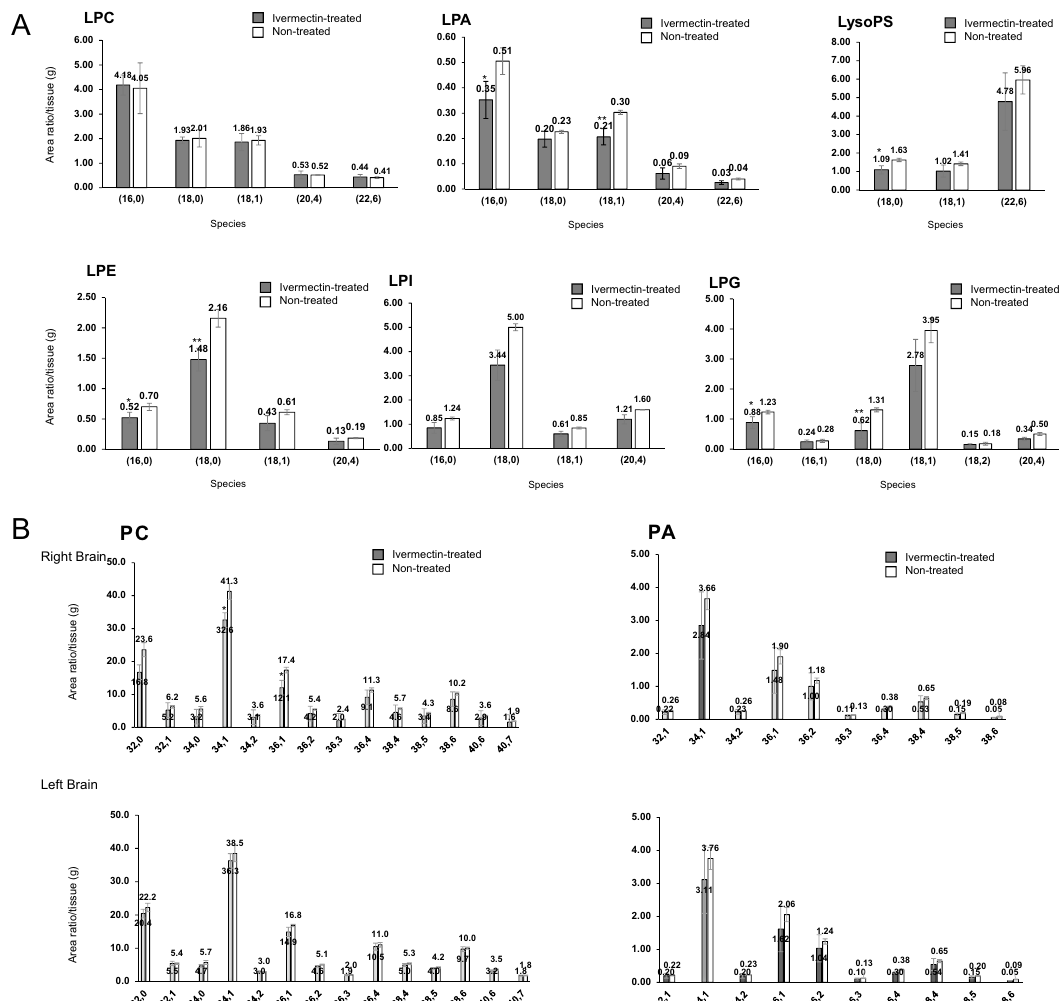
Figure 5. Quantitative change of LPLs, PC and PA in the brain RN mice by IVE-treatment. ( A ) Quantitative comparison of lysophosphatidylcholine (LPC), lysophosphatidyl acid (LPA), lysophosphatidylserine (LPS), lysophosphatidylethanolamine (LPE), lysophosphatidylinositol (LPI), and lysophosphatidylglycerol (LPG) between non-treated and IVE-treated mice ( n = 3 per group) in the irradiated area at 5.5 months after irradiation in the brain radiation necrosis (RN) model. ( B ) Quantitative comparison of phosphatidylcholine (PC) and phosphatidyl acid (PA) between non-treated and IVE-treated mice ( n = 3 per group) in the irradiated area at 5.5 months after irradiation in the RN model. Upper graphs indicate the right hemisphere and lower graphs indicate the left hemisphere (non-treated: n = 3 and IVE-treated: n = 3). * P < 0.05, ** P < 0.01, unpaired t‑